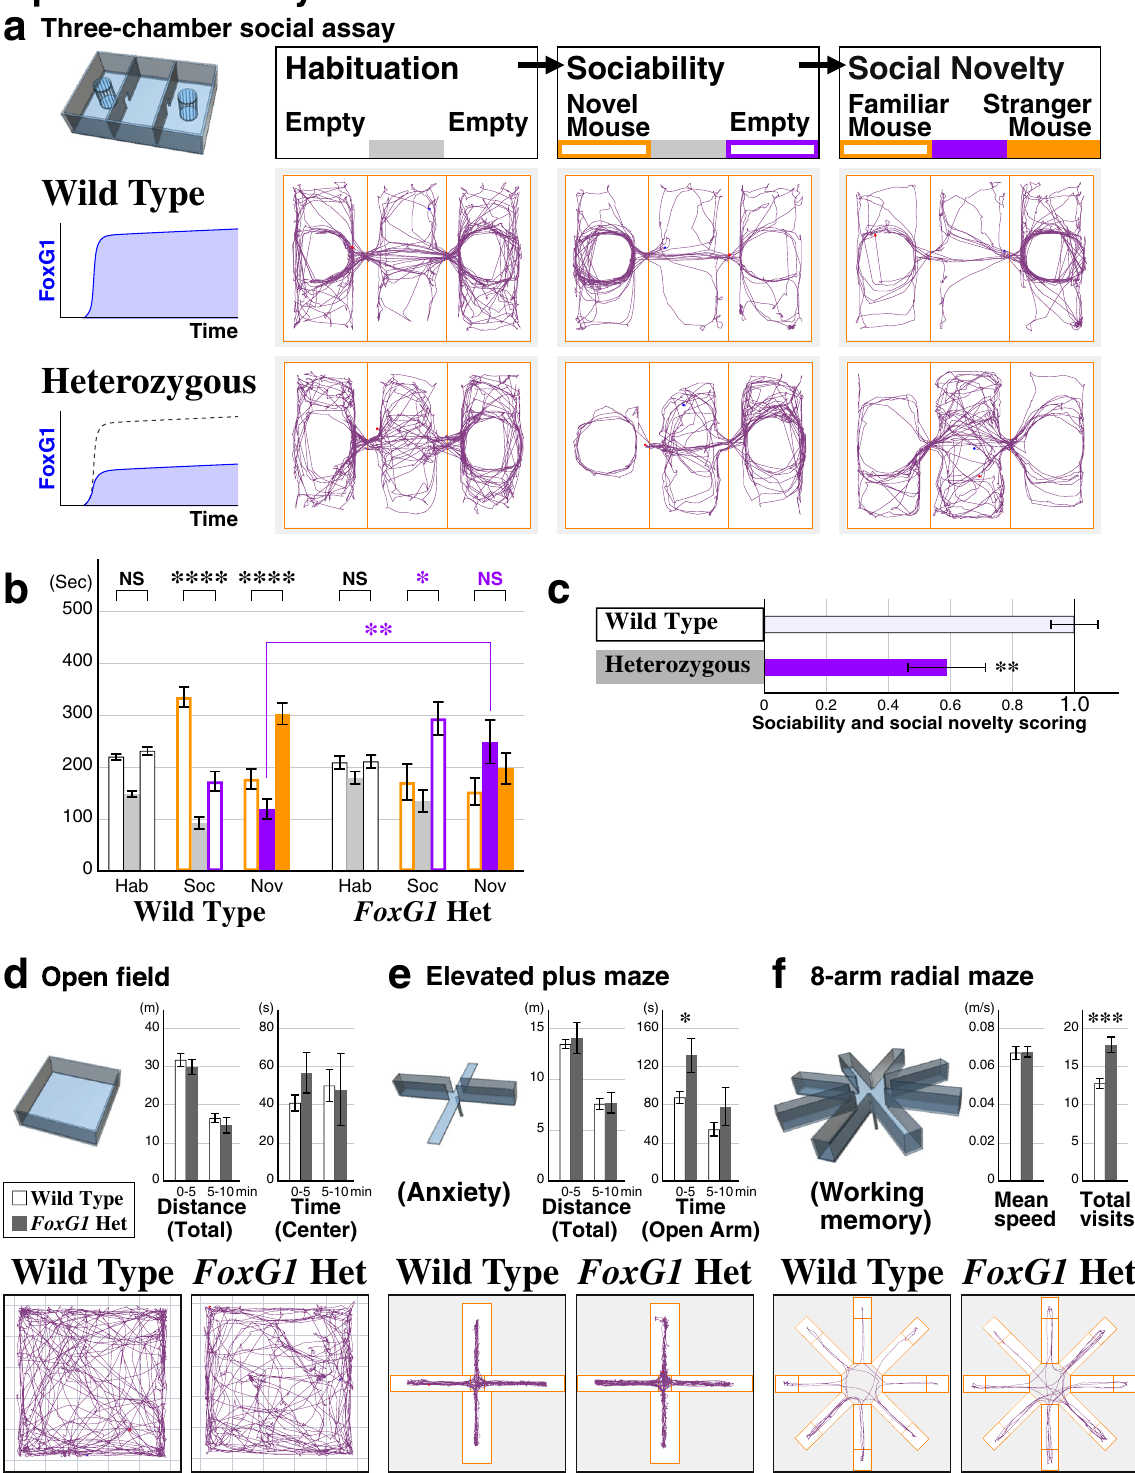
model also spares glial FoxG1 expression 45 – 47 unlike the Het- erozygous model (Fig. 2c). We fi rst asked if neuronal FoxG1 haploinsuf fi ciency is suf fi cient to reproduce the ASD-phenotypes observed in FoxG1 Heterozygous animals (Fig. 2m, Glu + GABA Low, traces in Supplementary Fig. 1). Indeed, FoxG1 haploinsuf fi ciency in both pyramidal and GABAergic neurons led to social behavioral